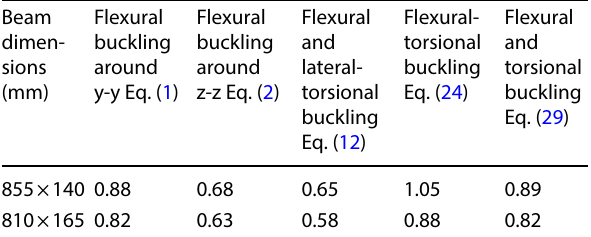
Table 5 The effect of beam dimensions on beam stability Flexural Beam buckling dimen- around sions y-y Eq. (1) (mm)